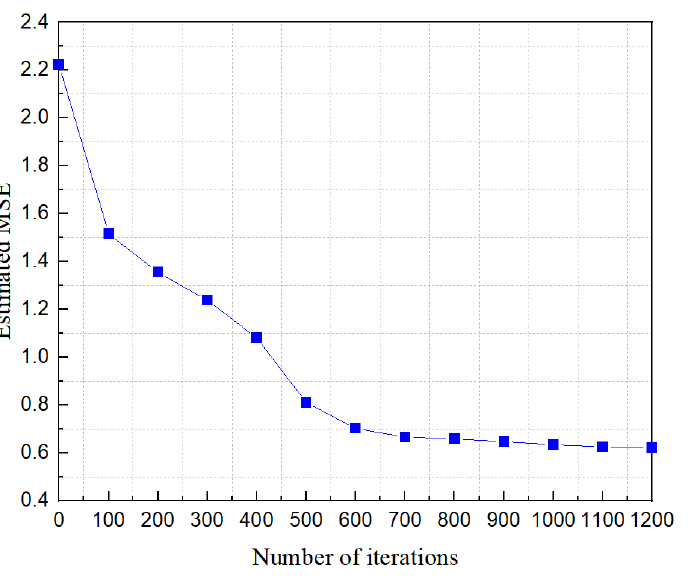
Figure 10. Reduction of error in angle calculation with the number of